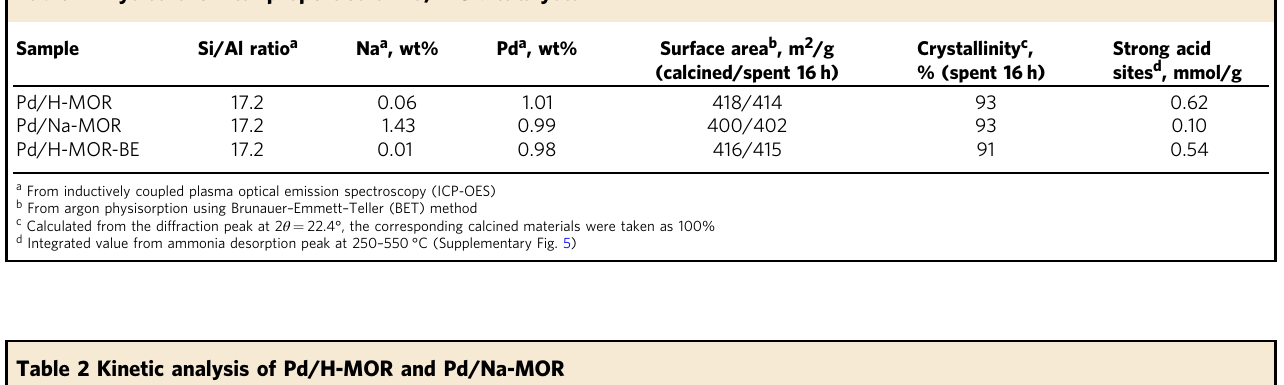
Fig. 1 Catalytic activity of Pd/Al 2 O 3 and various Pd/mordenite catalysts. a Light-off curves, b 65 h stability test without regeneration, and c stability test with continuous short pulse regeneration (averaged values including methane slip during regeneration). Conditions: 1 vol% CH 4 , 4 vol% O 2 , 0 or 5 vol% H 2 O, bal. N 2 ; gas hourly space velocity (GHSV) = 70,000h − 1 ; T = 415 °C for stability tests; lean operation: 10 min; regeneration (short rich operation): 3 s; d magni fi cation of four cycles with regeneration over Pd/H-MOR and Pd/Na-MOR. Prior to the tests, the catalysts were degreened at 550 °C for 30 min in 1 vol% CH 4 , 4 vol% O 2 , 95 vol% N 2 Table 1 Physico-chemical properties of Pd/MOR catalysts